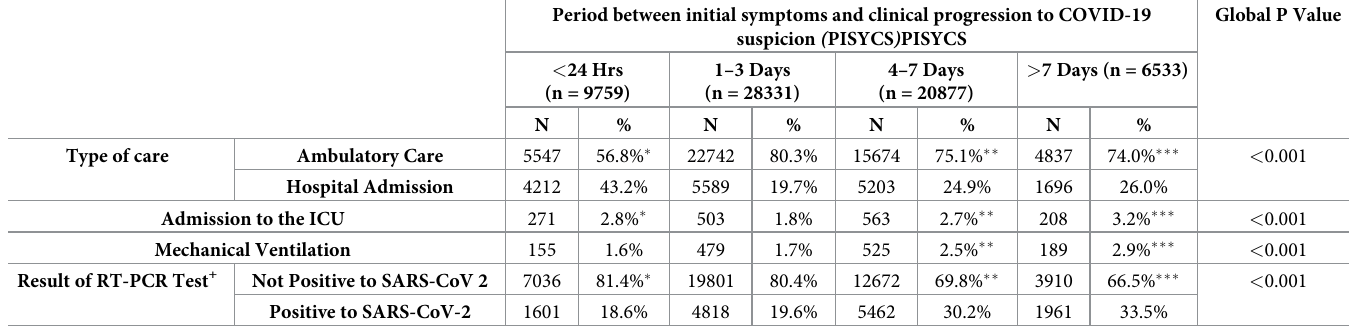
Table 2. Medical decisions according period between initial symptoms and clinical progression to COVID-19 suspicion